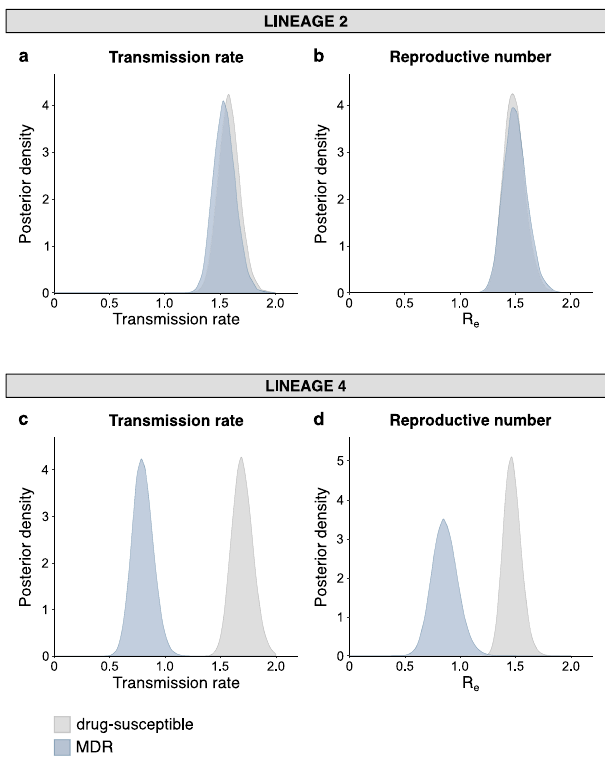
Fig. 3 | The transmission fi tness of MDR M. tuberculosis compared to drug- susceptible M.tuberculosis bylineage. Posteriordistributionsofthetransmission rate and effective reproductive number of drug-susceptible and MDR strains, estimatedby fi ttingatwo-typebirth-deathmodelonarandomsubsetofsequences belonging to L2 ( N =200) ( a , b ) and L4 ( N =200) ( c , d